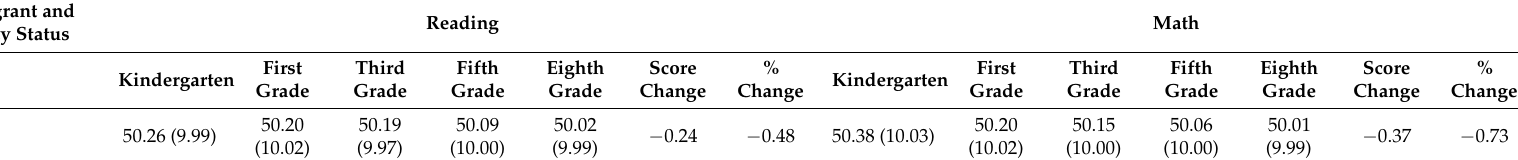
Table 3. Child academic achievement from kindergarten to eighth grade by immigrant status and poverty